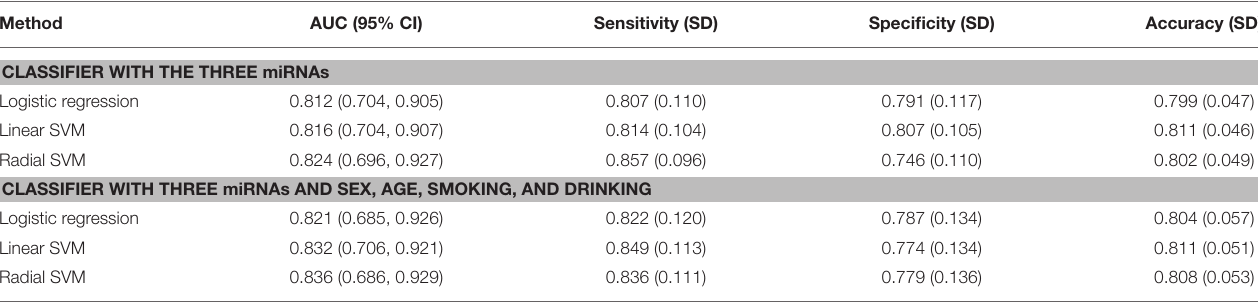
TABLE 4 | Diagnostic performance in discriminating ESCC from the